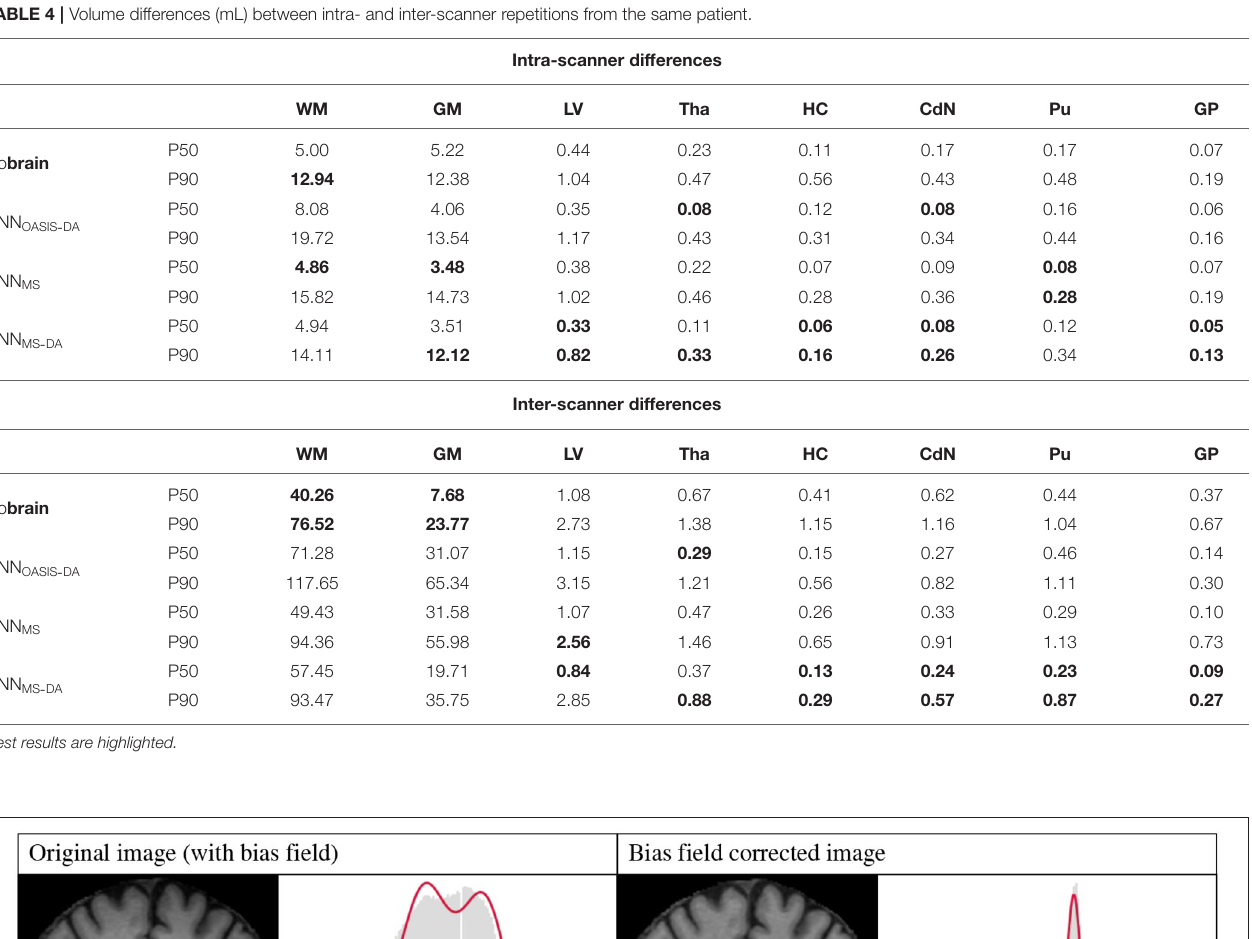
popular to skip bias field correction when using deep learning approaches, and instead allow the networks to learn the bias-field mechanisms, with good results (Kamnitsas et al.,